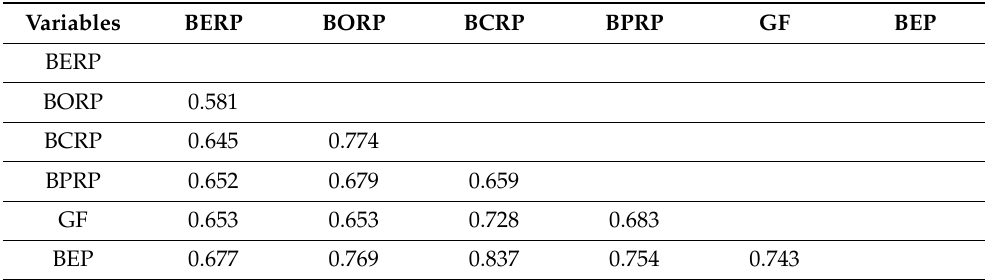
Table 6. Discriminant validity using Heterotrait–Monotrait Ratio